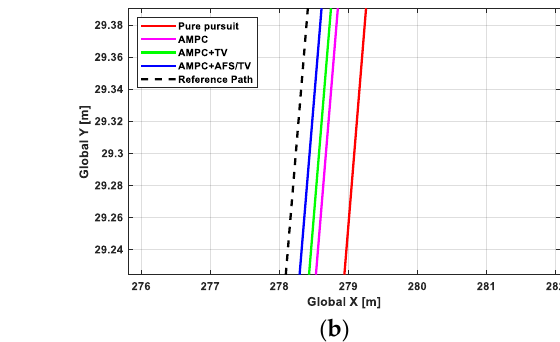
Figure 12. ( a ) Yaw rate error and ( b ) side-slip angle.